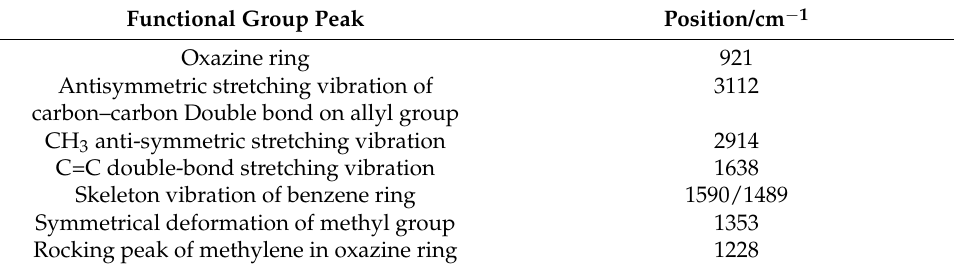
Figure 6. GPC of benzoxazine (eugenol) .